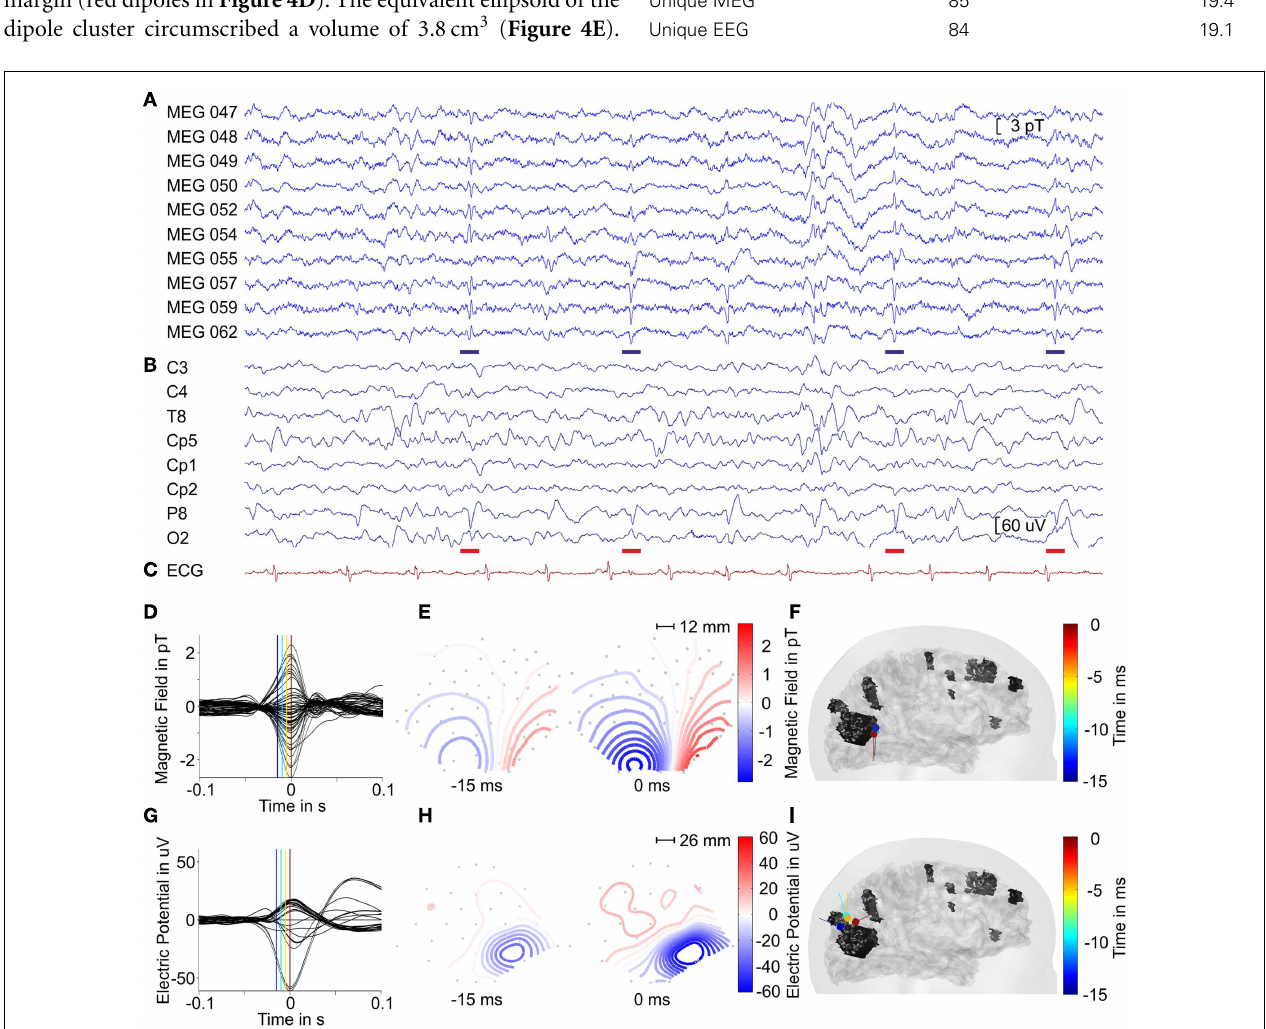
red lines in (D,G) ] of averaged signals.The gray dots indicate sensor positions with a geometrical scale as labeled. For positioning with respect to the head, please compare to Figure 1 . (F,I) Lateral views on the head model with ECD traces of averaged interictal spikes with color coded time information from − 15 to 0ms with respect to peak latency for MEG and EEG,